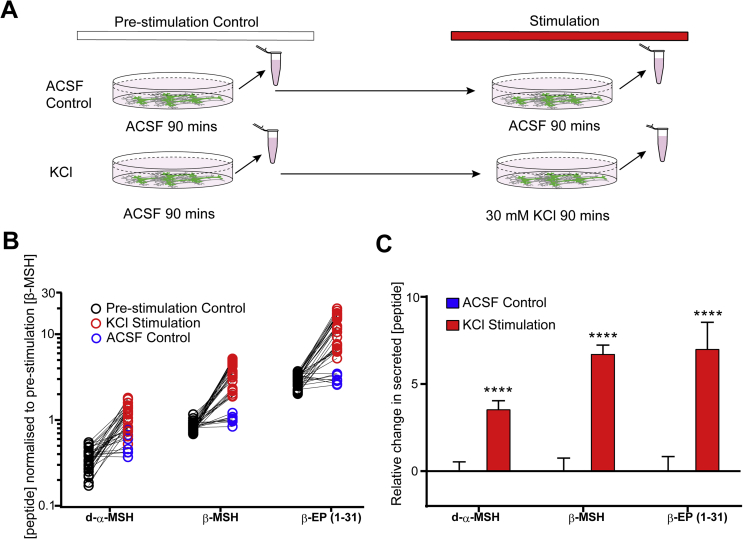
Regulated secretion of POMC-derived peptides. A) Experimental schematic for quantifying the stimulated secretion of POMC-derived peptides in hPSC-derived hypothalamic neurons by LC-MS/MS. B) Secreted d-α-MSH, β-MSH and β-EP (1-31) peptides in pre-stimulation controls (black circles), 30 mM KCl stimulations (red circles) and ACSF controls (blue circles). Molar peptide concentrations were normalised to the mean pre-stimulation β-MSH concentration. N = 4 independent experiments with 4–8 technical replicates per experiment. C) KCl-induced changes in secreted peptide concentration were calculated from data shown in (B) for each technical replicate by subtracting the pre-stimulation peptide concentrations from the ACSF control or KCl stimulation condition, and normalising to mean concentrations seen in ACSF control-stimulated cultures. KCl stimulation significantly (P < 3 × 10−5) increased the concentrations of d-α-MSH, β-MSH and β-EP (1-31). KCl, potassium chloride. Error bars show SEM. ****, P < .0001.